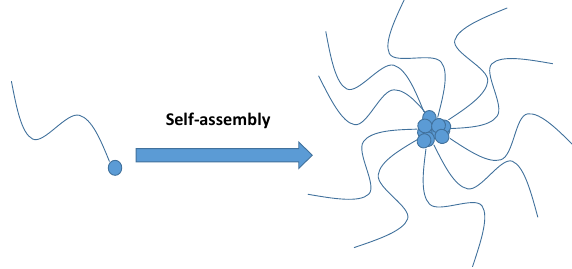
Figure 2. Illustration of self-assembled nanoparticles from hydrophobic–hydrophilic nanoconjugates. The blue dot represents the hydrophobic association.